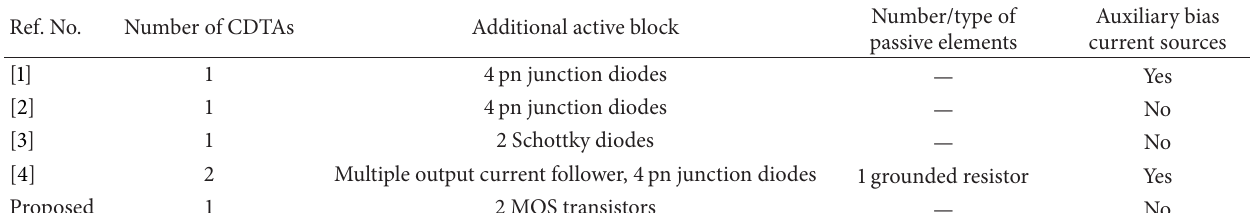
Table 1: Summary of available CDTA-based FWR.